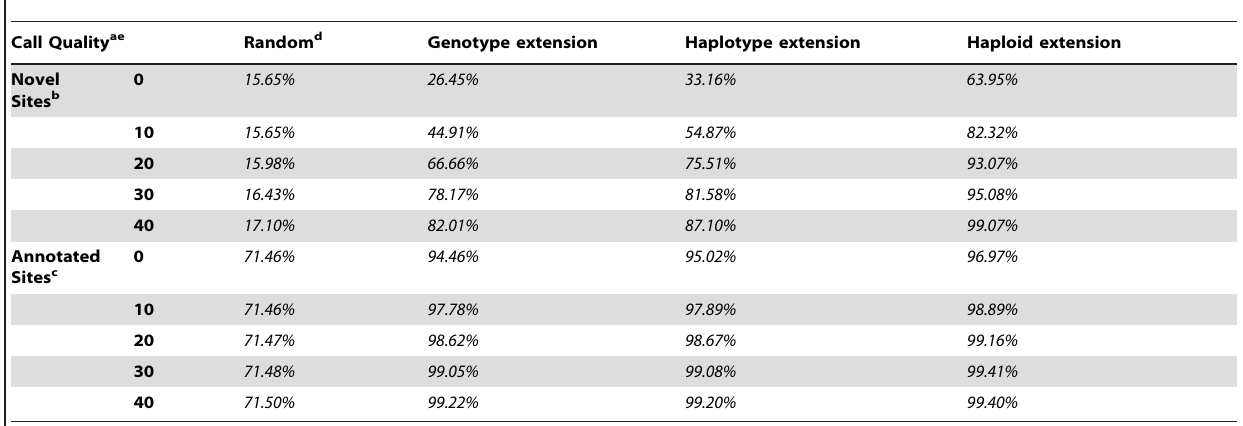
Table 1. Concordance between GWAS IBD and whole-exome sequencing